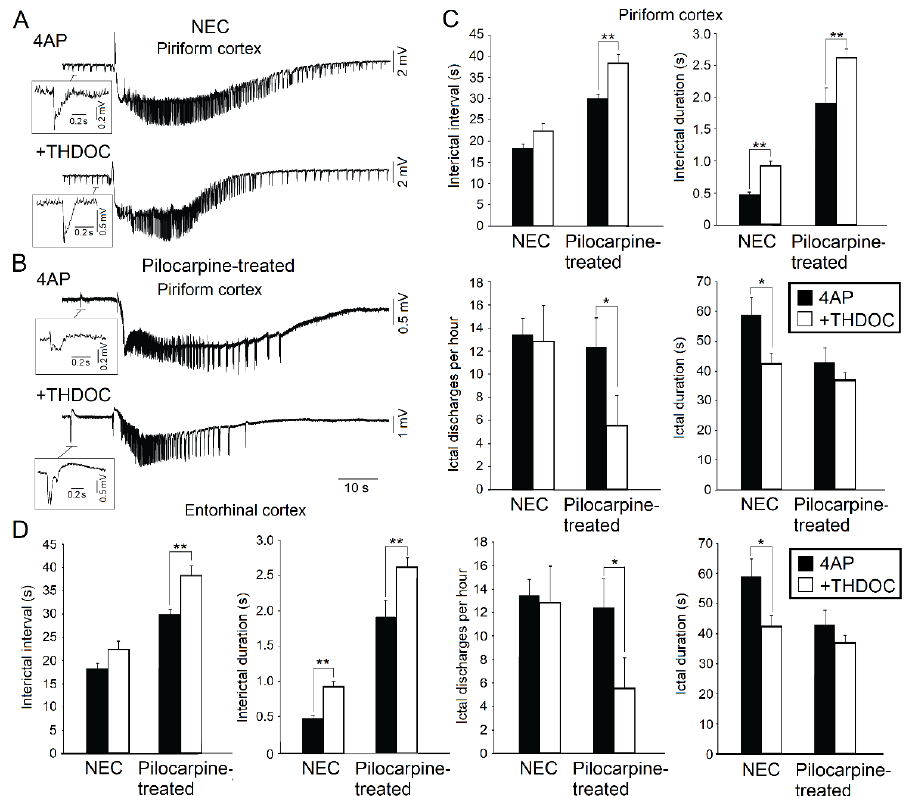
Figure 2. ( A ): Effects induced by allotetrahydrodeoxycorticosterone (THDOC) on the 4AP-induced epileptiform activity generated in vitro by the piriform cortex obtained from non-epileptic control (NEC) rodents. Note that both interictal (enlarged sample) and ictal discharges can be recorded during application of 4AP and following the addition of THDOC. ( B ): 4AP-induced interictal and ictal discharges recorded from the piriform cortex of brain slices obtained from epileptic (Pilocarpine-treated) rodents in 4AP and following bath application of THDOC. ( C ): Quantification of the interictal events and ictal events recorded from the piriform cortex during 4AP application and after application of THDOC in brain slices obtained from NEC and pilocarpine-treated animals. ( D ): Quantification of the interictal and ictal events recorded from the entorhinal cortex during 4AP application and after application of THDOC in brain slices obtained from NEC and pilocarpine-treated animals. * indicates p < 0.05; ** indicates p < 0.01. Panels shown in this figure are modified from the study by Shiri et al. [17].